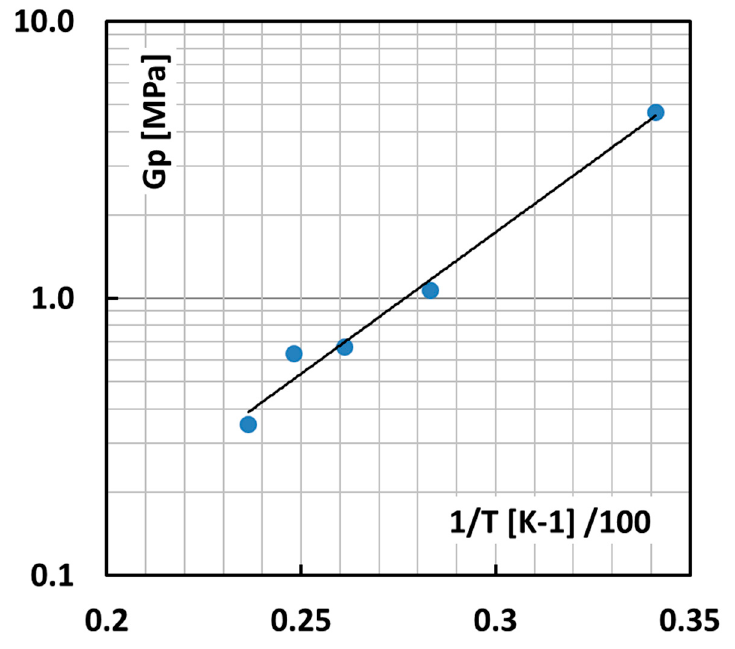
Figure 9. Strain-hardening modulus, representing the network density by Equation (5), as a function of temperature, after our own Neo Hookean fits on the work of Duffo et al. [25]. The abscissa is the reciprocal absolute temperature multiplied by 100 for convenience.